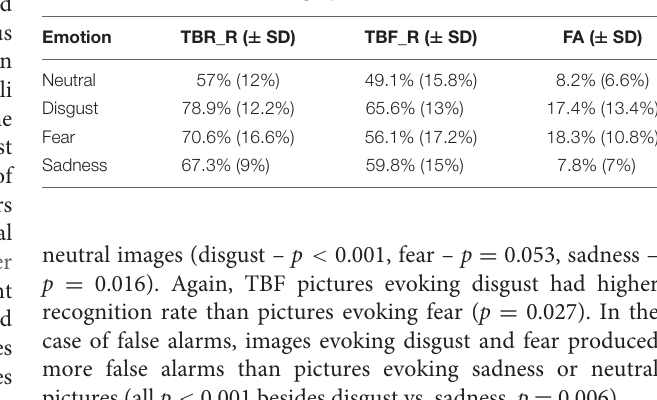
TABLE 1 | The recognition rates for correctly recognized to-be-remembered (TBR) and to-be-forgotten (TBF) items as well as false alarms for each emotional